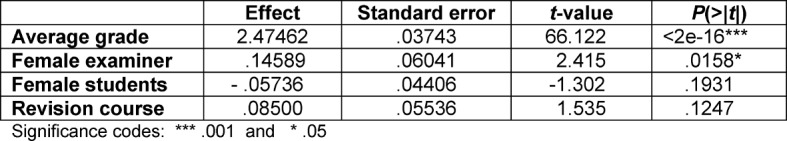
Multivariant regression model of the grading estimated by genders of examiners and students as well as the studets participation in the revision course. The avergae grade corresponds to the reference group of male students examined by male examiners.